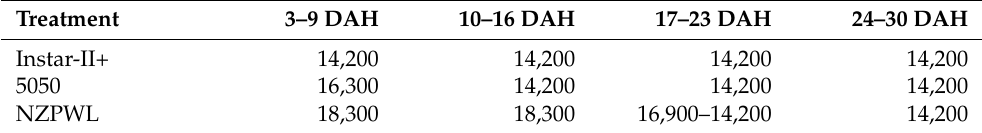
Table 1. Feed-particle density in each experimental tank by treatment throughout the experimental period given as the number of live-fed particles per liter (L − 1 ). Three grams of live feeds were added to each tank containing 2000 larvae for each feeding event in the respective ratios of instar-I and instar-II+ Artemia . The range presented for the NZPWL treatment at 17–23 DAH reflects the change in feed-particle density from the start to the finish of the week as the ratio of instar-I to instar-II+ Artemia changed during this